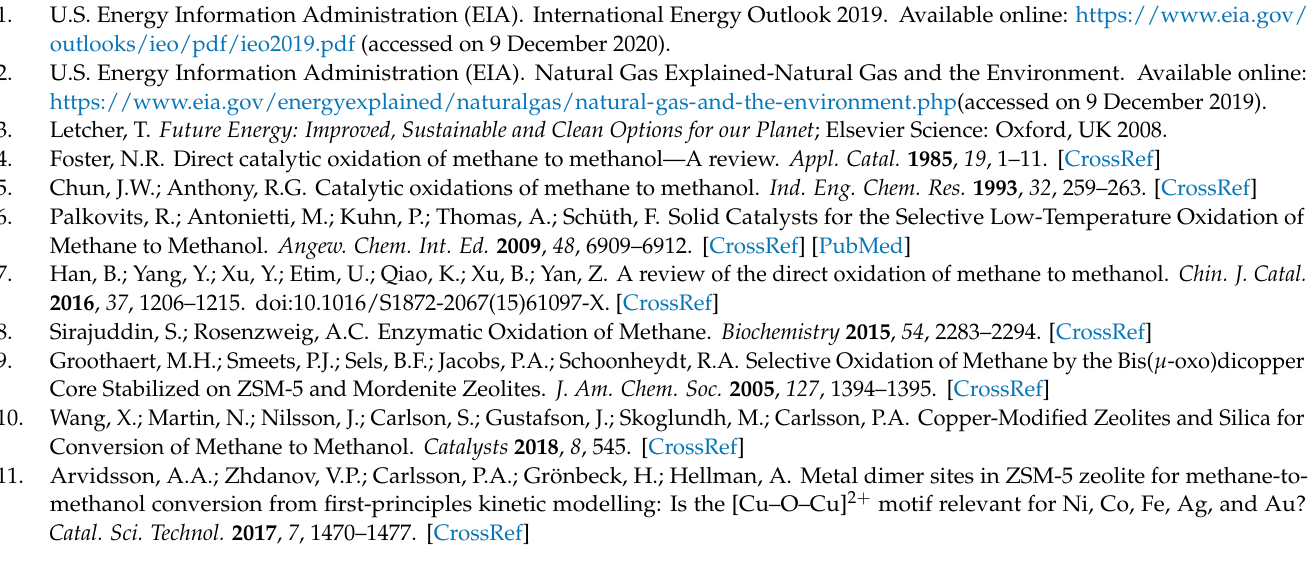
intermediates in Z 2 [Cu 2 O], Table S3: Vibrational frequencies of reaction intermediates in Z 2 [Cu 2 OH], Figure S1: Unit cell and larger scale structure of SSZ-13, Figure S2: Reaction mechanism over Z 2 [Cu 2 O] in relative energies, Figure S3: Reaction mechanism over Z 2 [Cu 2 O] showing the effect of using +U, Figure S4: Reaction mechanism over Z 2 [Cu 2 O] showing the change in free energy when using the harmonic approximation for reaction species, Figure S5: Reaction mechanism over Z2[Cu2OH] in relative energies, Figure S6: Reaction mechanism over Z 2 [Cu 2 OH] showing the effect of using +U, Figure S7: Reaction mechanism over Z 2 [Cu 2 OH] showing the change in free energy when using the harmonic approximation for reaction species, Figure S8: Micro-kinetic model, Figure S9: Coverages, Figure S10: Reaction mechanism over Cu-ZSM-5 in relative